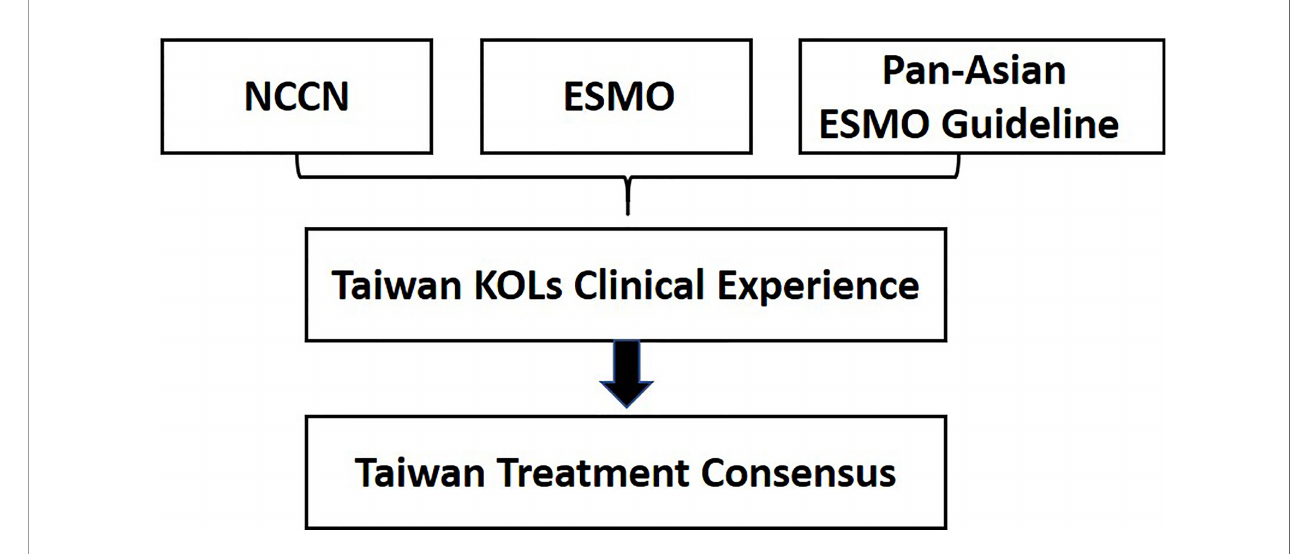
FIGURE 1 | Approach of Consensus